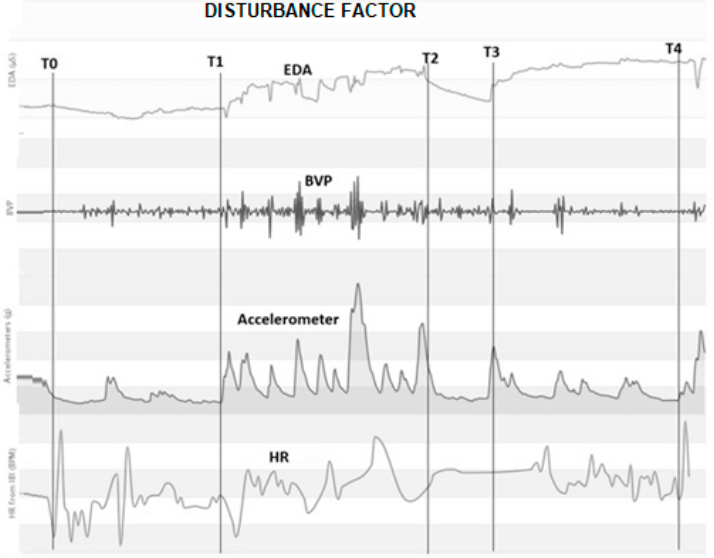
Figure 3. Biometric parameters during the typical simulation: EDA—Electro-Dermal activity, BVP—Blood-Volume pulse, HR—Heart-Rate. T0—Beginning of the collision avoidance scenario, T1—The moment when the disturbance factor occurs, T2—Disturbance factor stops, T3—Secondar0079 collision avoidance (easy task), T4—Simulation ends. J. Mar. Sci. Eng. 2020 , 8 , x FOR PEER REVIEW